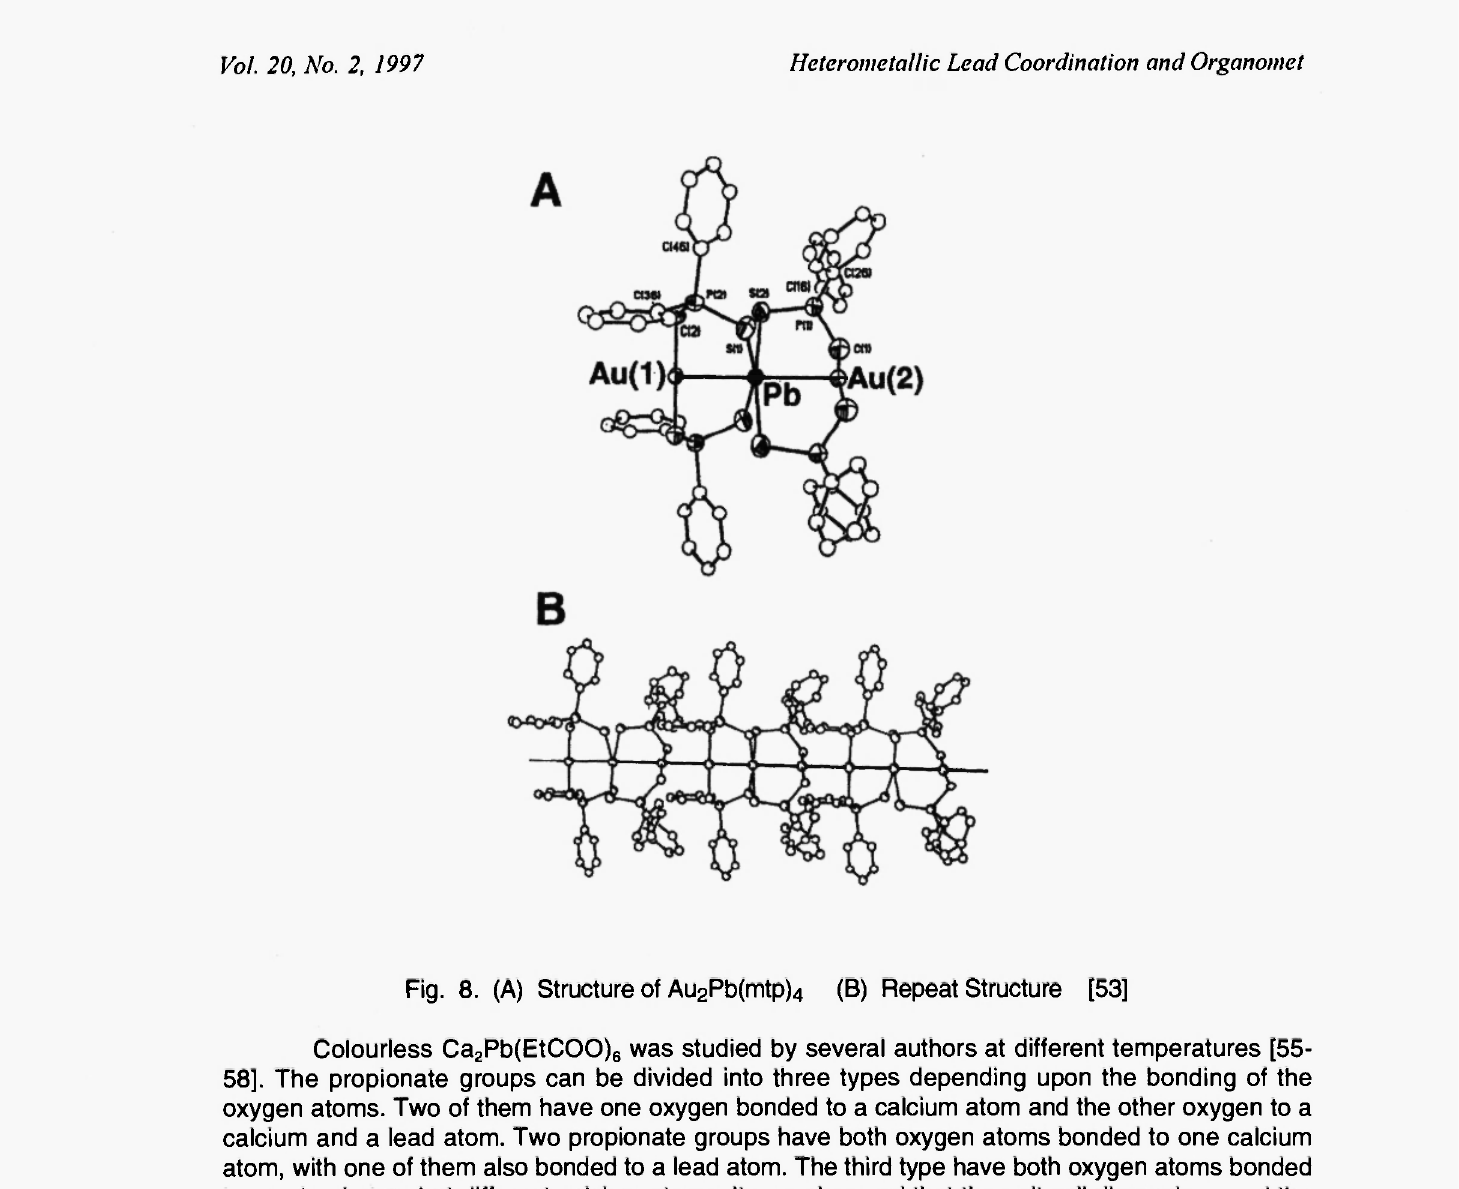
Pb(mtp) (B) Repeat Structure 2 4